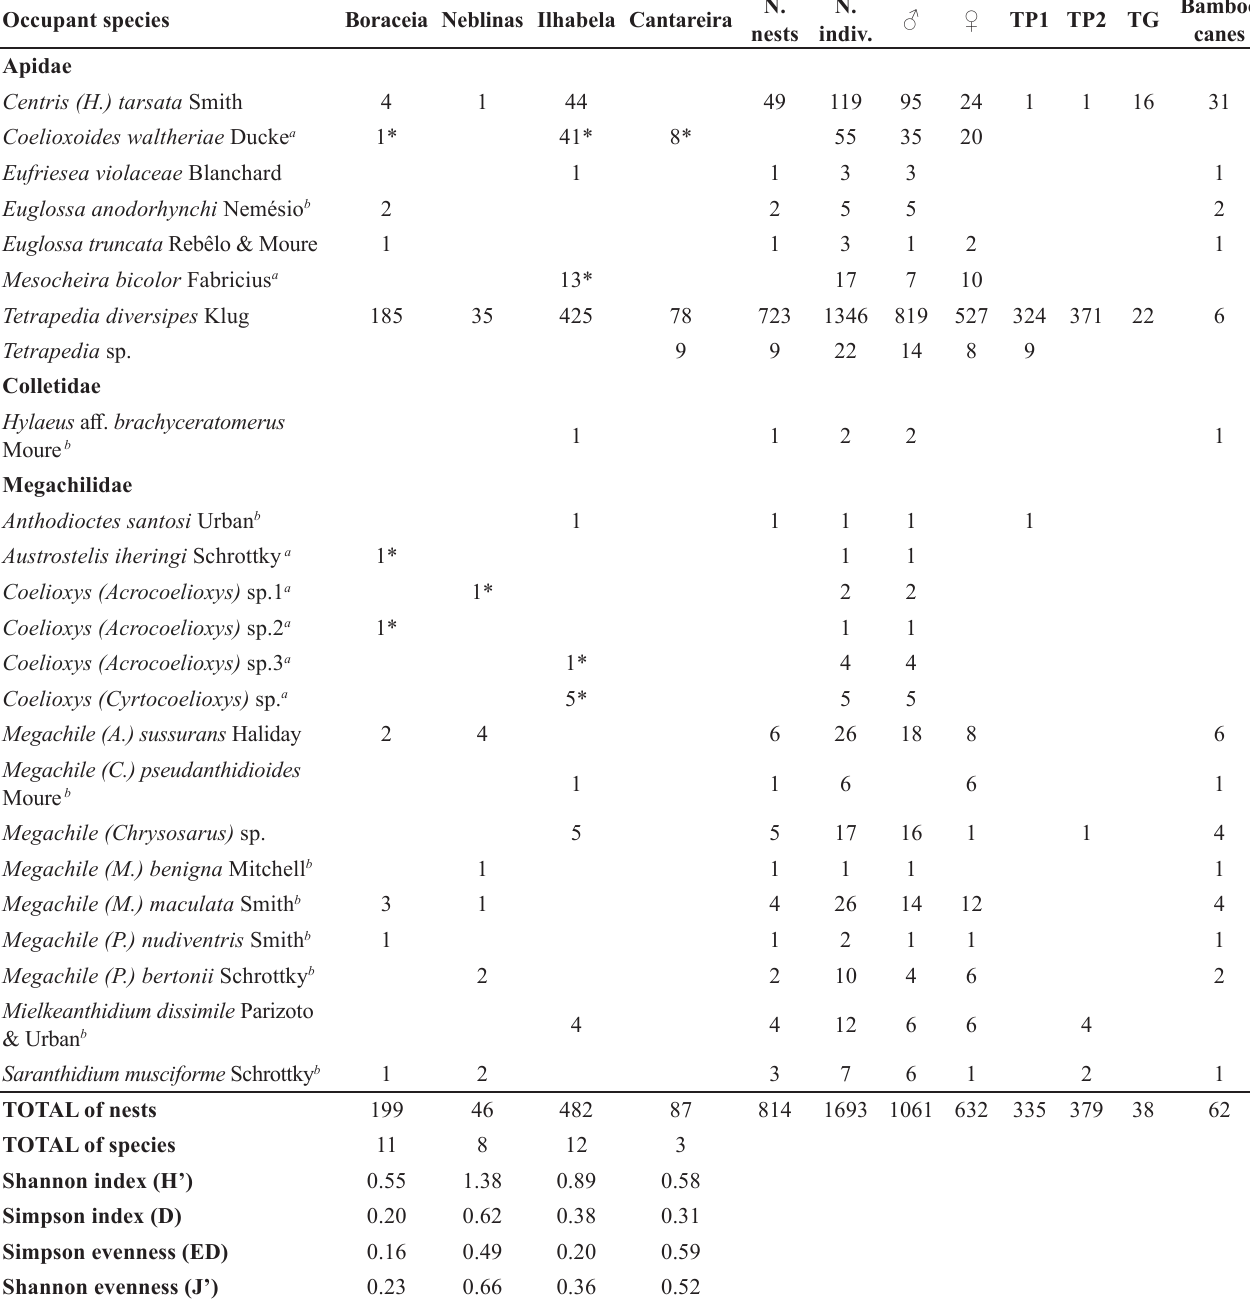
Table 1 . Number of nests and individuals of the bee species that used trap nests in four study areas sampled from March 2007 to February 2009. Three sizes of paper tubes were used: TP1: 0.6 cm in diameter and 5.8 cm in length, TP2: 0.6 cm in diameter and 8.5 cm in length,